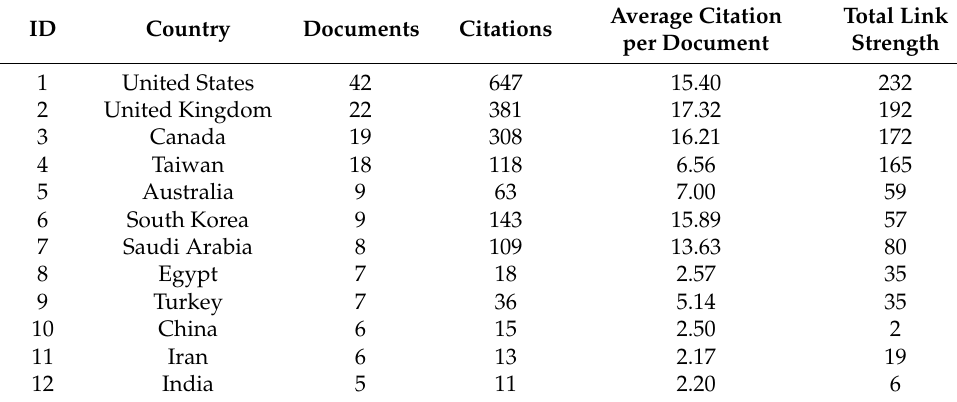
Table 6. The magnitudes concerning document and citation as per